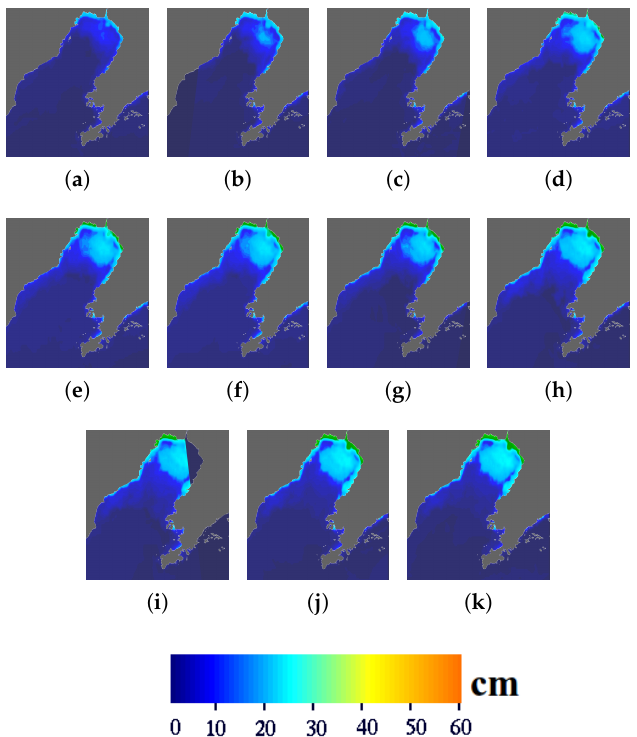
Figure 17. Sea ice thickness modeled applying the HIGHTSI model corresponding to the RADARSAT-2 SAR imagery used: ( a ) 2 january 2013; ( b ) 6 January 2013; ( c ) 9 January 2013; ( d ) 16 January 2013; ( e ) 23 January 2013; ( f ) 26 January 2013; ( g ) 2 February 2013; ( h ) 9 February 2013; ( i ) 12 February 2013; (j ) 16 February 2013; ( k ) 19 February 2013.